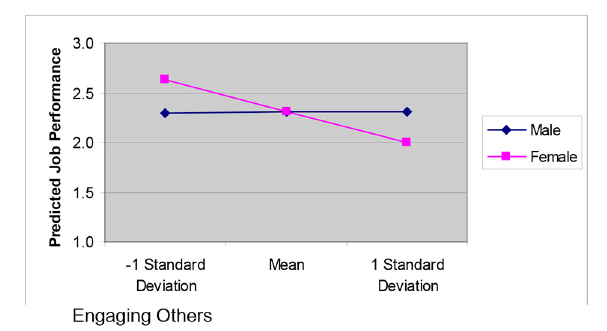
FIGURE 1 | Interactive effects of the engaging others leadership competencies on performance.